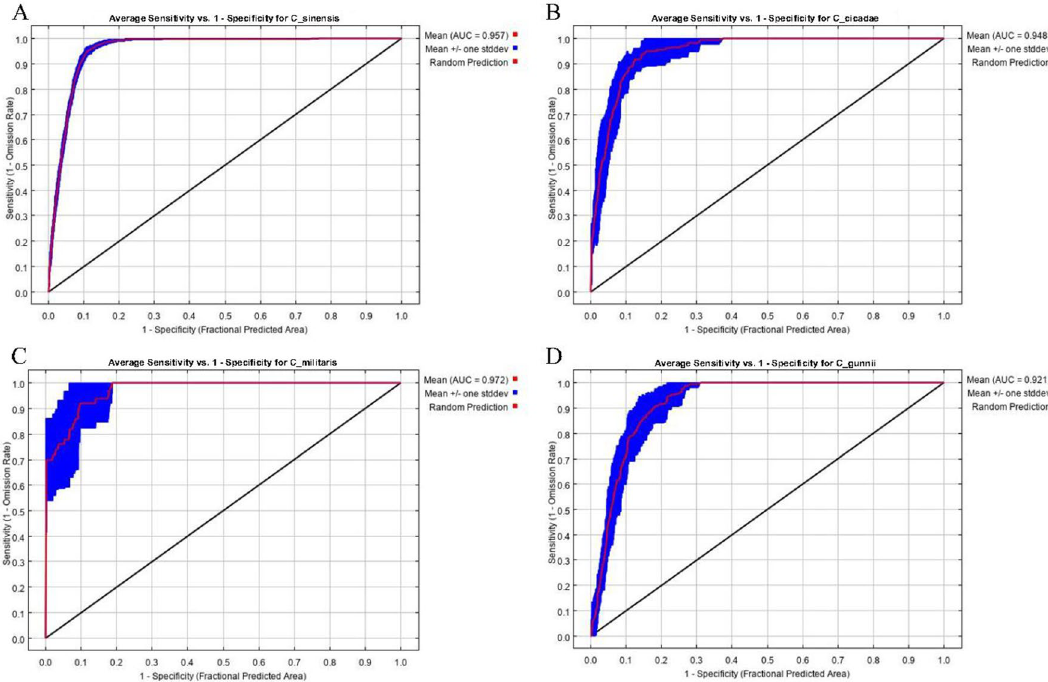
Figure 7. ROC curve of MaxEnt model of Cordyceps . ( A ) ROC curve of MaxEnt model of C. sinensis . ( B ) ROC curve of MaxEnt model of C. cicadae . ( C ) ROC curve of MaxEnt model of C. militaris . ( D ) ROC curve of MaxEnt model of C. gunnii